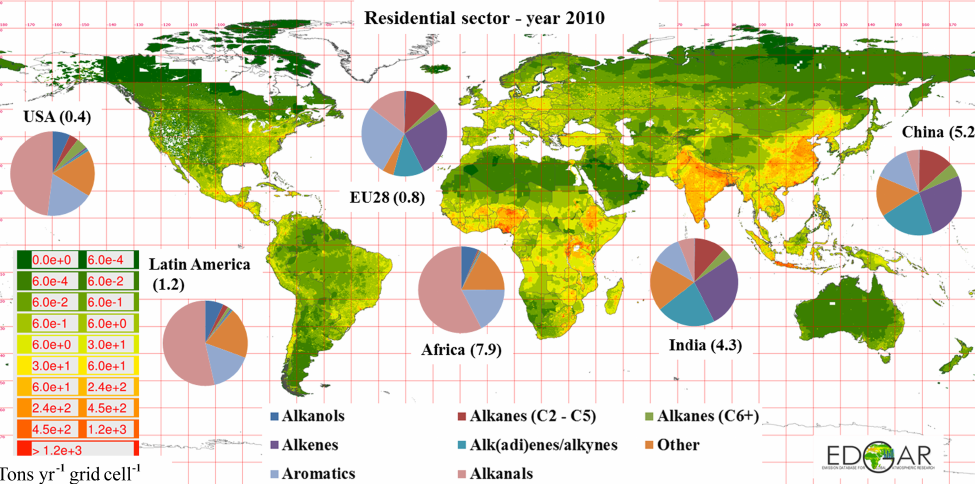
Figure 3. NMVOC emission grid map at 0.1 × 0.1 ◦ resolution from the residential sector in 2010. The relative contribution of eight ag- gregated NMVOC species is reported in the pie charts for major world regions (numbers in brackets refer to total NMVOC emissions (in kilotons) for the residential sector for each region).